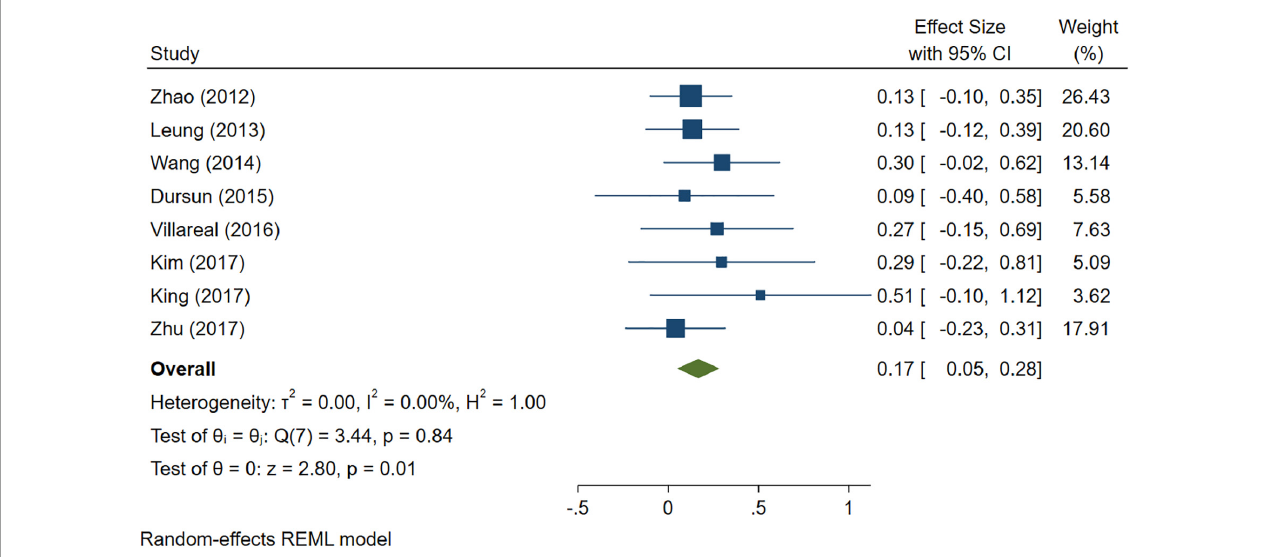
FIGURE7 Forest plot of pooled Hedge’s g depicting high IL-1 β concentration in mild cognitive impairment (MCI) samples compared to controls.